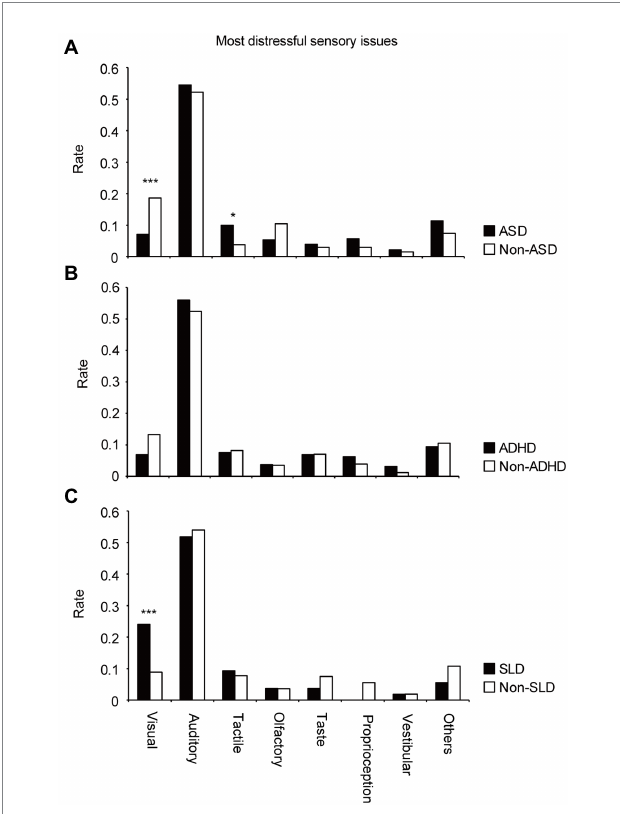
FIGURE 2 Differences in appearance rates of sensory issues in each modality for the most distressful sensory issues in the (A) ASD and non-ASD groups, (B) ADHD and non-ADHD groups, and (C) SLD and non-SLD